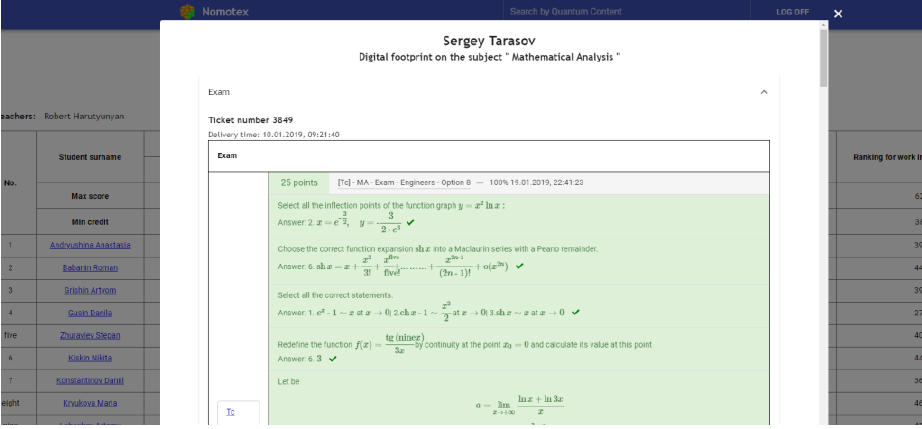
Fig. 9. The ticket for the exam in the student's personal account in the DLS